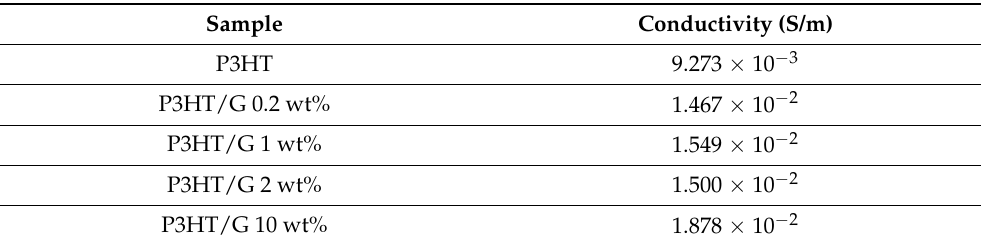
Table 1. Conductivity measurements reported by Chang et al. for different P3HT/G nanocomposites. Adapted from [8], American Scientific Publishers,